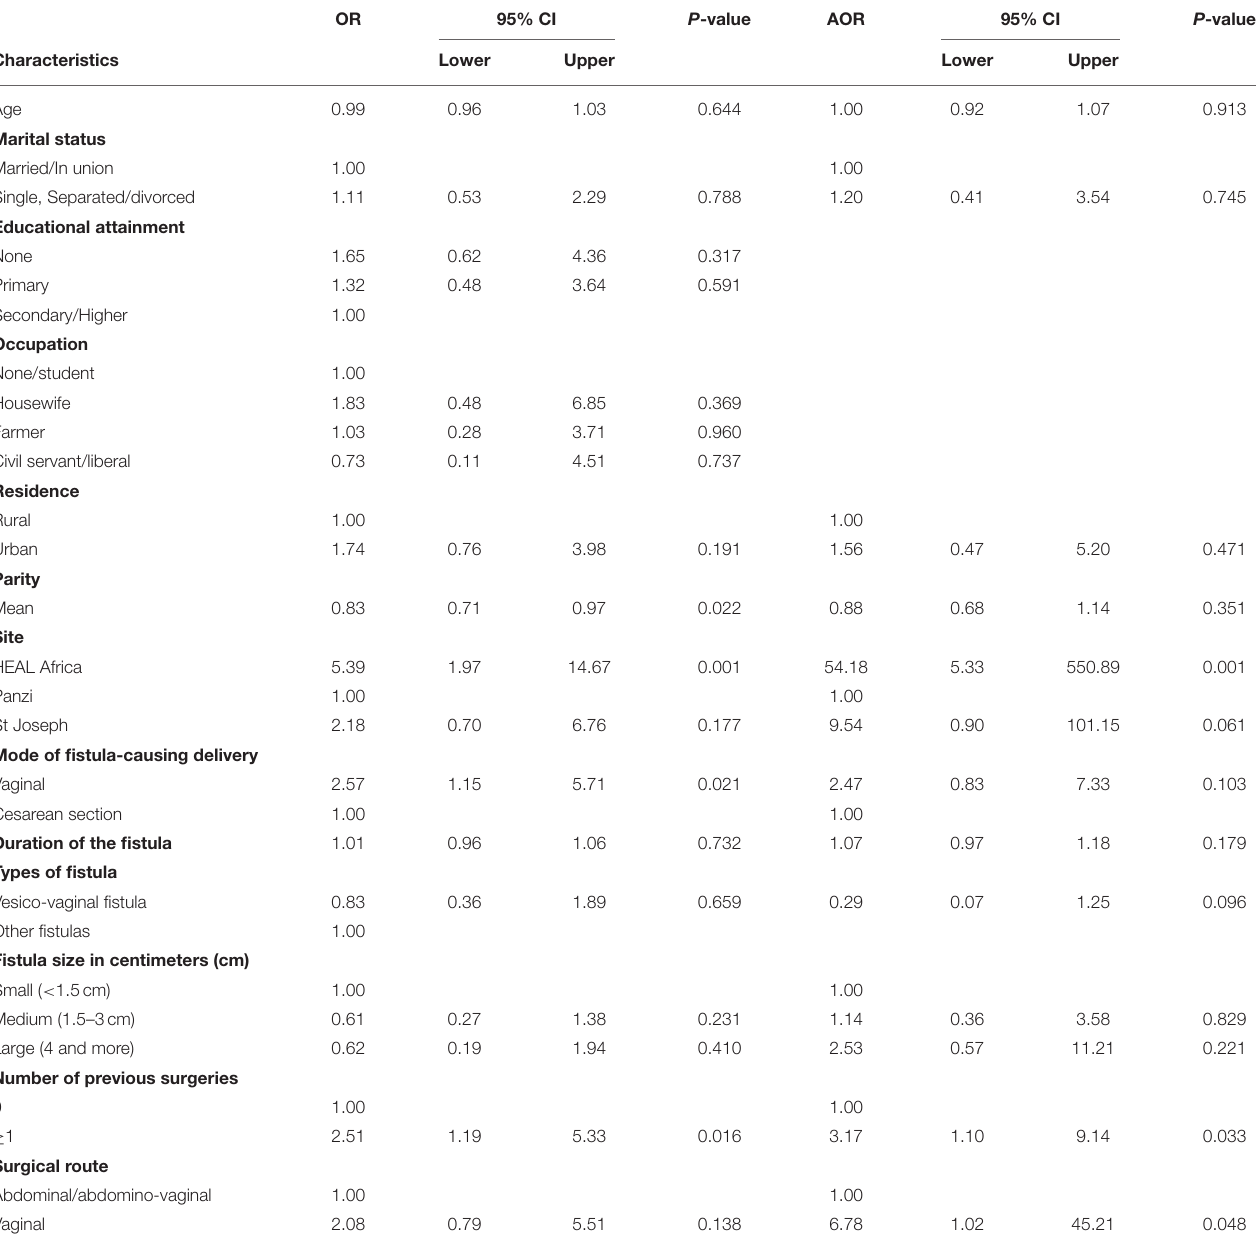
OR P -value 95% CI P